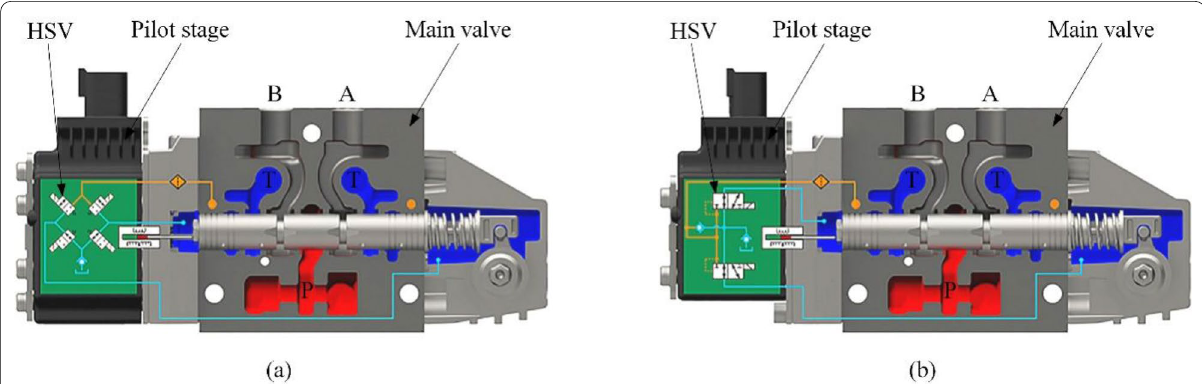
Figure 23 Proportional multiple valves developed by Sauer-Danfoss: a pilot stage with four 2/2 HSVs, b pilot stage with two 3/2 HSVs